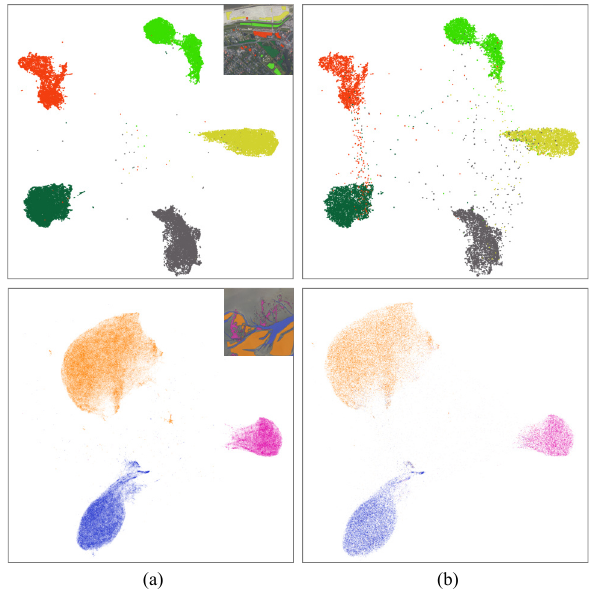
Figure 3. Supervised UMAP. The 2D embedding of the training data (a) and the (b) test data that are embedded in the learned 2D feature space (b) are